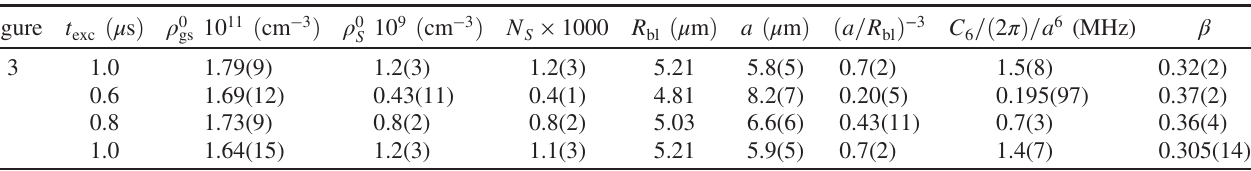
TABLE I. Experimental parameters. t denotes the time of laser excitation from the ground to the Rydberg state. ρ 0 exc measured ground-state density. ρ 0 the derived peak spin density, N the derived number of total spins. R S S from the excitation time and laser coupling strength. a denotes the Wigner-Seitz radius, C 6 =a 6 the van der Waals coefficient, and β is the exponent of the stretching exponential derived from a fit to the relaxation